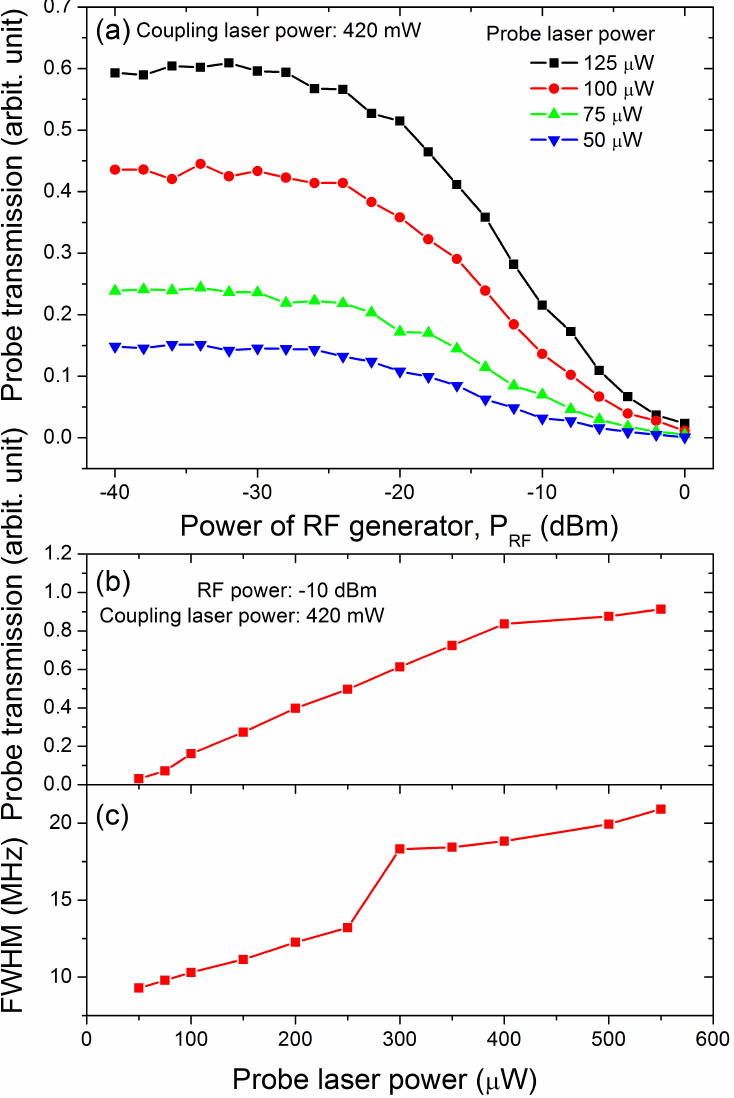
Figure 3. ( a ) Probe optical transmission response on the applied RF power at various probe laser powers. ( b ) At the optimized RF power of − 10 dBm and coupling laser intensity of 420 mW, the optical signal increases linearly with the probe laser intensity, but ( c ) the AT-spectral linewidth also almost linearly increases. An optimized probe laser power should keep a balance between